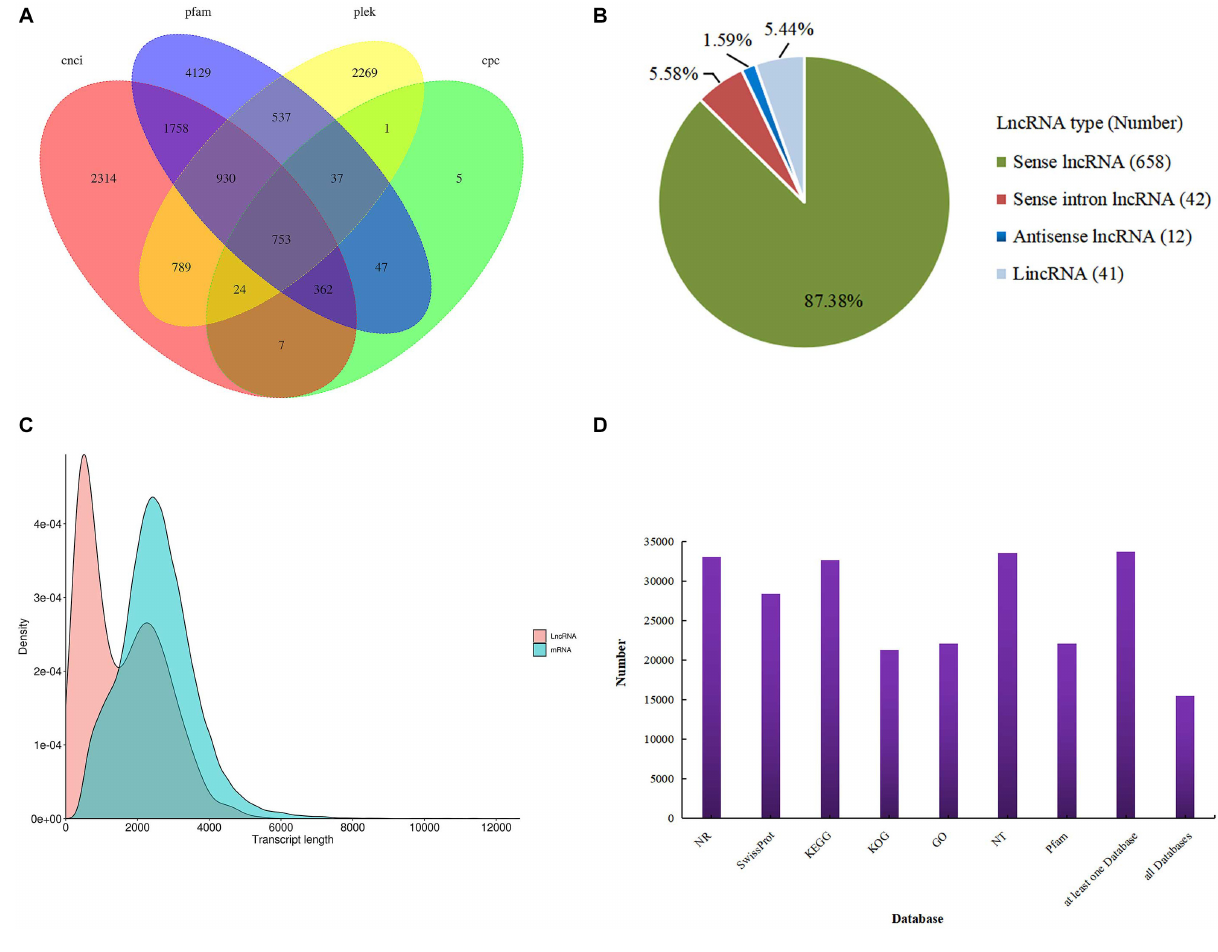
FIGURE 1 | Identification of lncRNAs. (A) Venn diagram of lncRNAs predicted by CNCI, CPC, Pfam, and PLEK methods. (B) Proportions of four types of lncRNA. (C) Density and length distributions of mRNAs and lncRNAs in P. canadensis . (D) Seven database annotation result